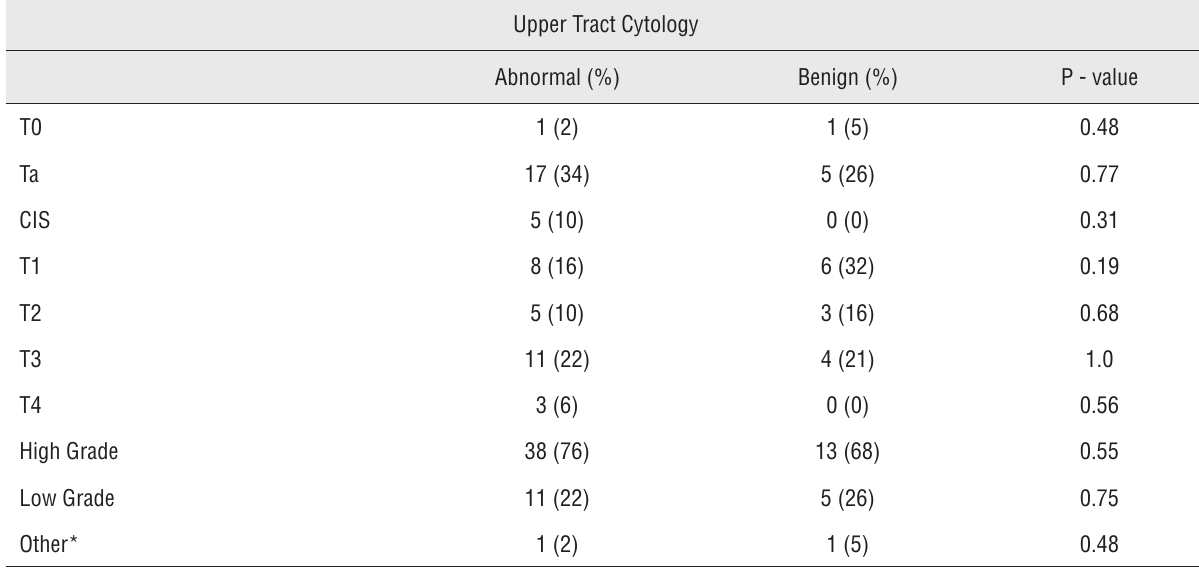
Table 2 - Correlation of UTC with tumor stage and